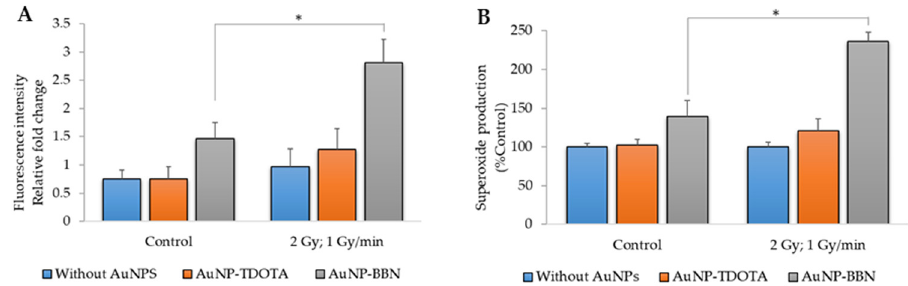
Figure 7 . ROS production in PC3 cells after irradiation with 2 Gy of γ -radiation (dose rate of 1 Gy/min) and incubation with AuNP-TDOTA and AuNP-BBN at a concentration of 36 µg Au/mL: